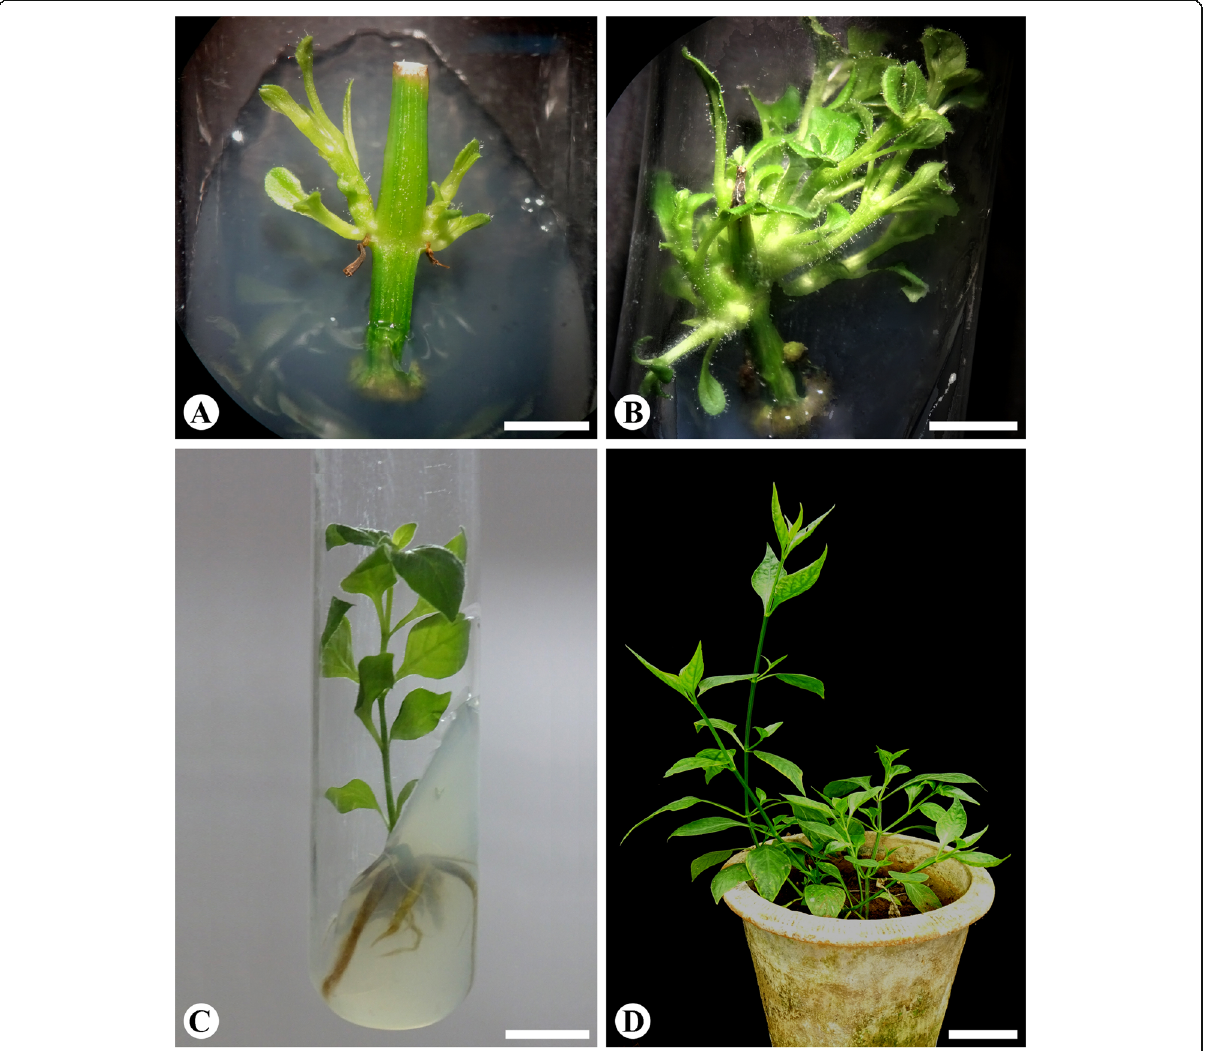
Fig. 1 Multiple-shoot regeneration from the nodal explants Andrographis alata . a Induction of axillary shoot buds on MS nutrient medium supplemented with 10 μ M BAP after 2 weeks of culture (bar = 0.25 cm). b Multiple shoots regenerated on MS nutrient medium supplemented with 10 μ M BAP after 4 weeks of culture (bar = 0.62 cm). c Adventitious root induction from regenerated shoots on ¼ strength MS